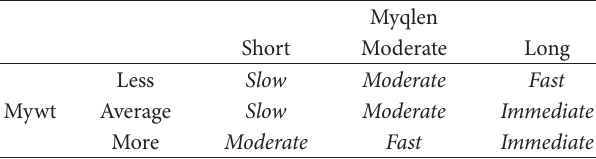
Table 2: Rule base for medium access (backoff